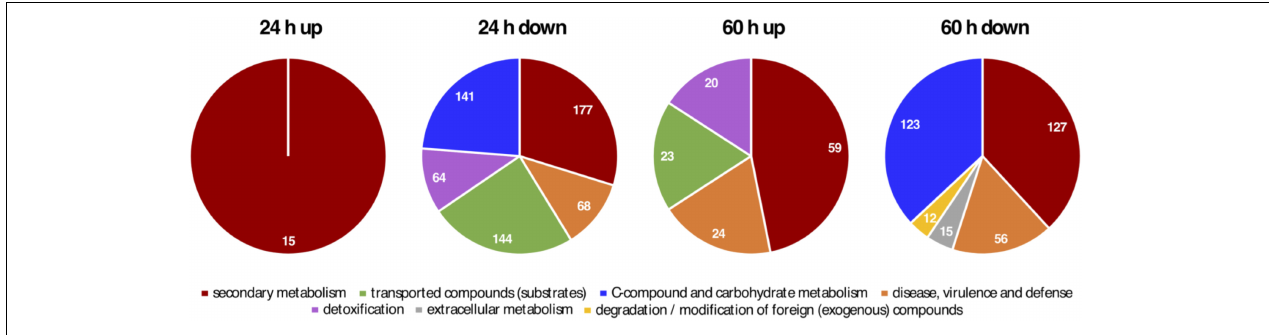
FIGURE 9 | Most significantly enriched FunCat gene categories of hosA mutant strains versus wildtype. Differentially expressed genes in the RNA-Seq analysis were used for a MIPS Functional Catalogue (FunCat) ontology analysis on the FungiFun2 platform (also see Supplementary Table S8 ). Pie charts illustrate the most significantly enriched FunCat categories of down- and up-regulated genes after 24 and 60 h of growth from hierarchy level 2. Numbers of genes related to the significant categories are displayed within the pie